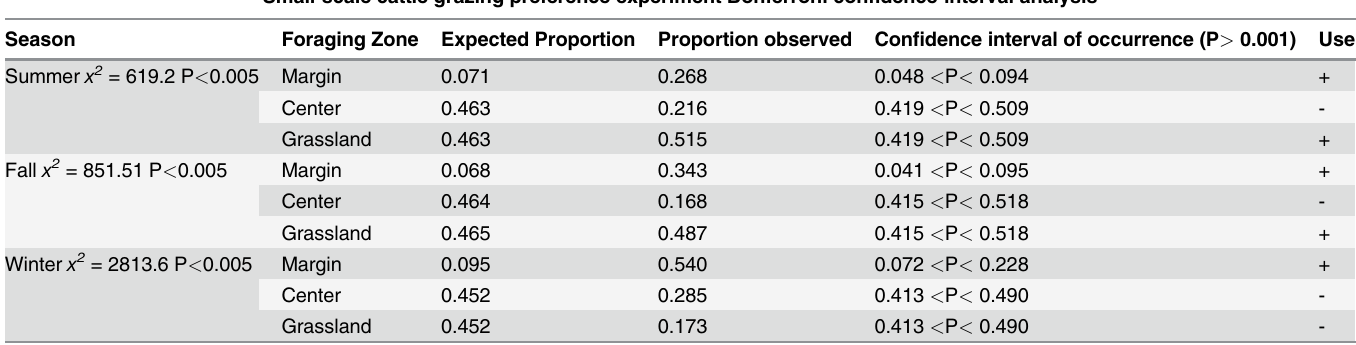
Cattle grazing record ’ s percentage by foraging zone and season v.s. foraging zone area cover %. Bonferroni con fi dence-interval results (P < 0.001) are given by the following signs: “ + ” indicates preference (utilization above availability); “ = ” indicates random (utilization equal to its availability); and “–” indicates avoidance (utilization below its